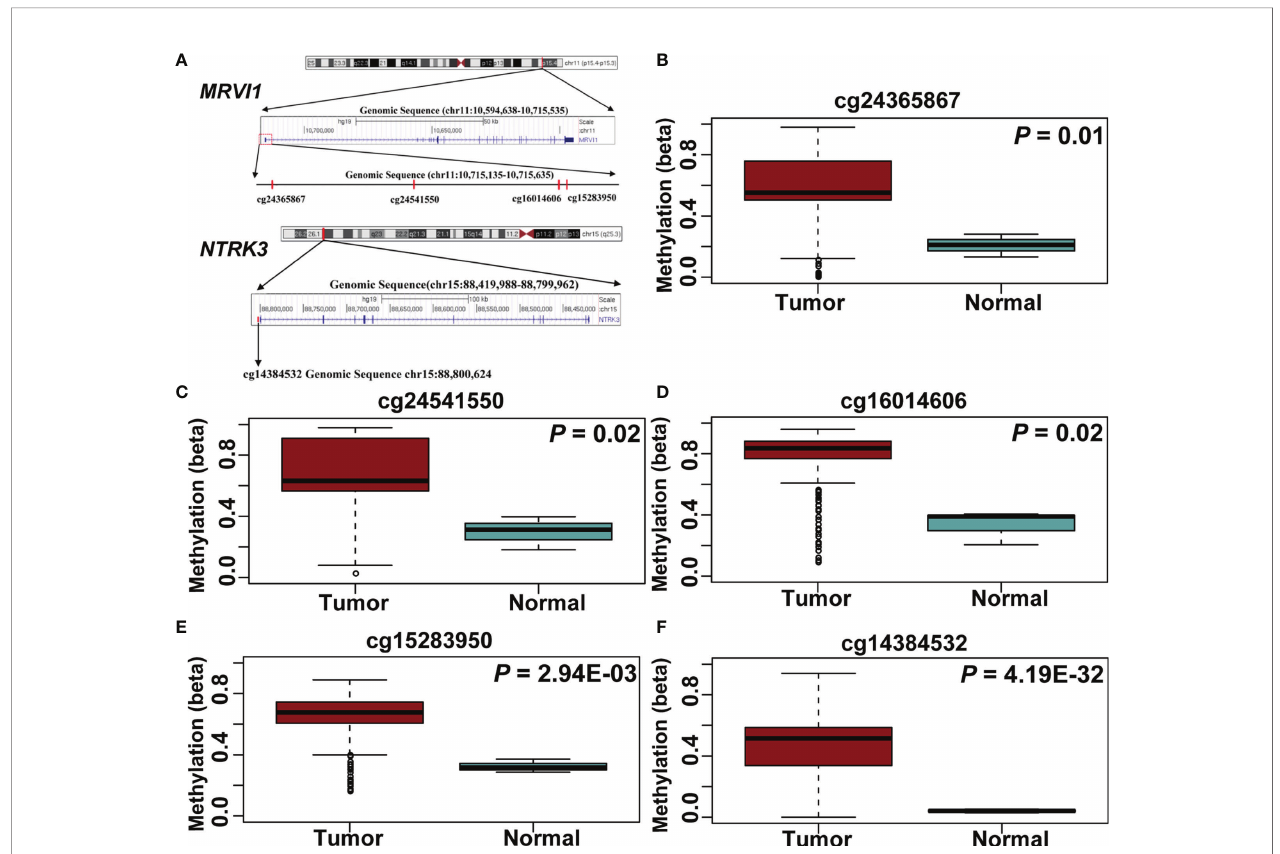
FIGURE 7 | Five CpG sites in MRVI1 and NTRK3 promoter regions. (A) The locations of CpG sites. The level of MRVI1 promoter DNA methylation (B – E) and NTRK3 promoter DNA methylation (F) presented as a box plot in the cervical cancer and normal cervical tissues.